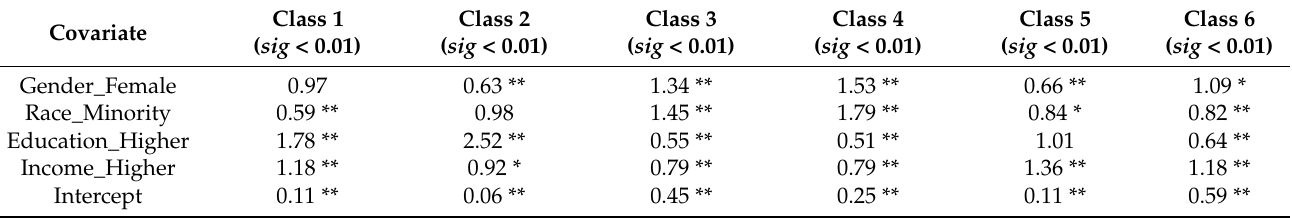
Table 4. The odds ratio for predictors on latent class membership ( N = 14,595).